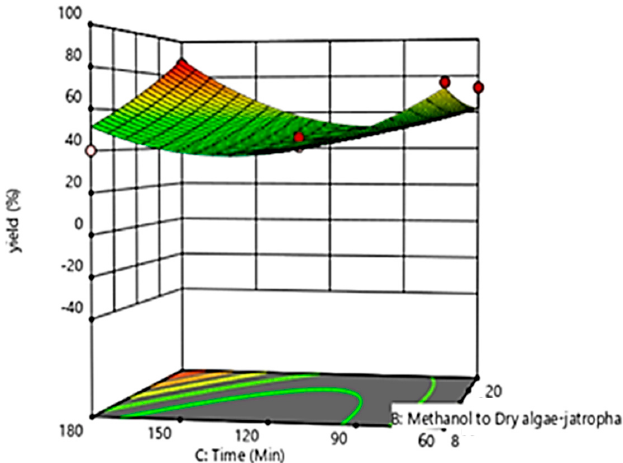
Figure 7. Biodiesel yield (%) vs. methanol/oil ratio (%) vs. reaction time (min).